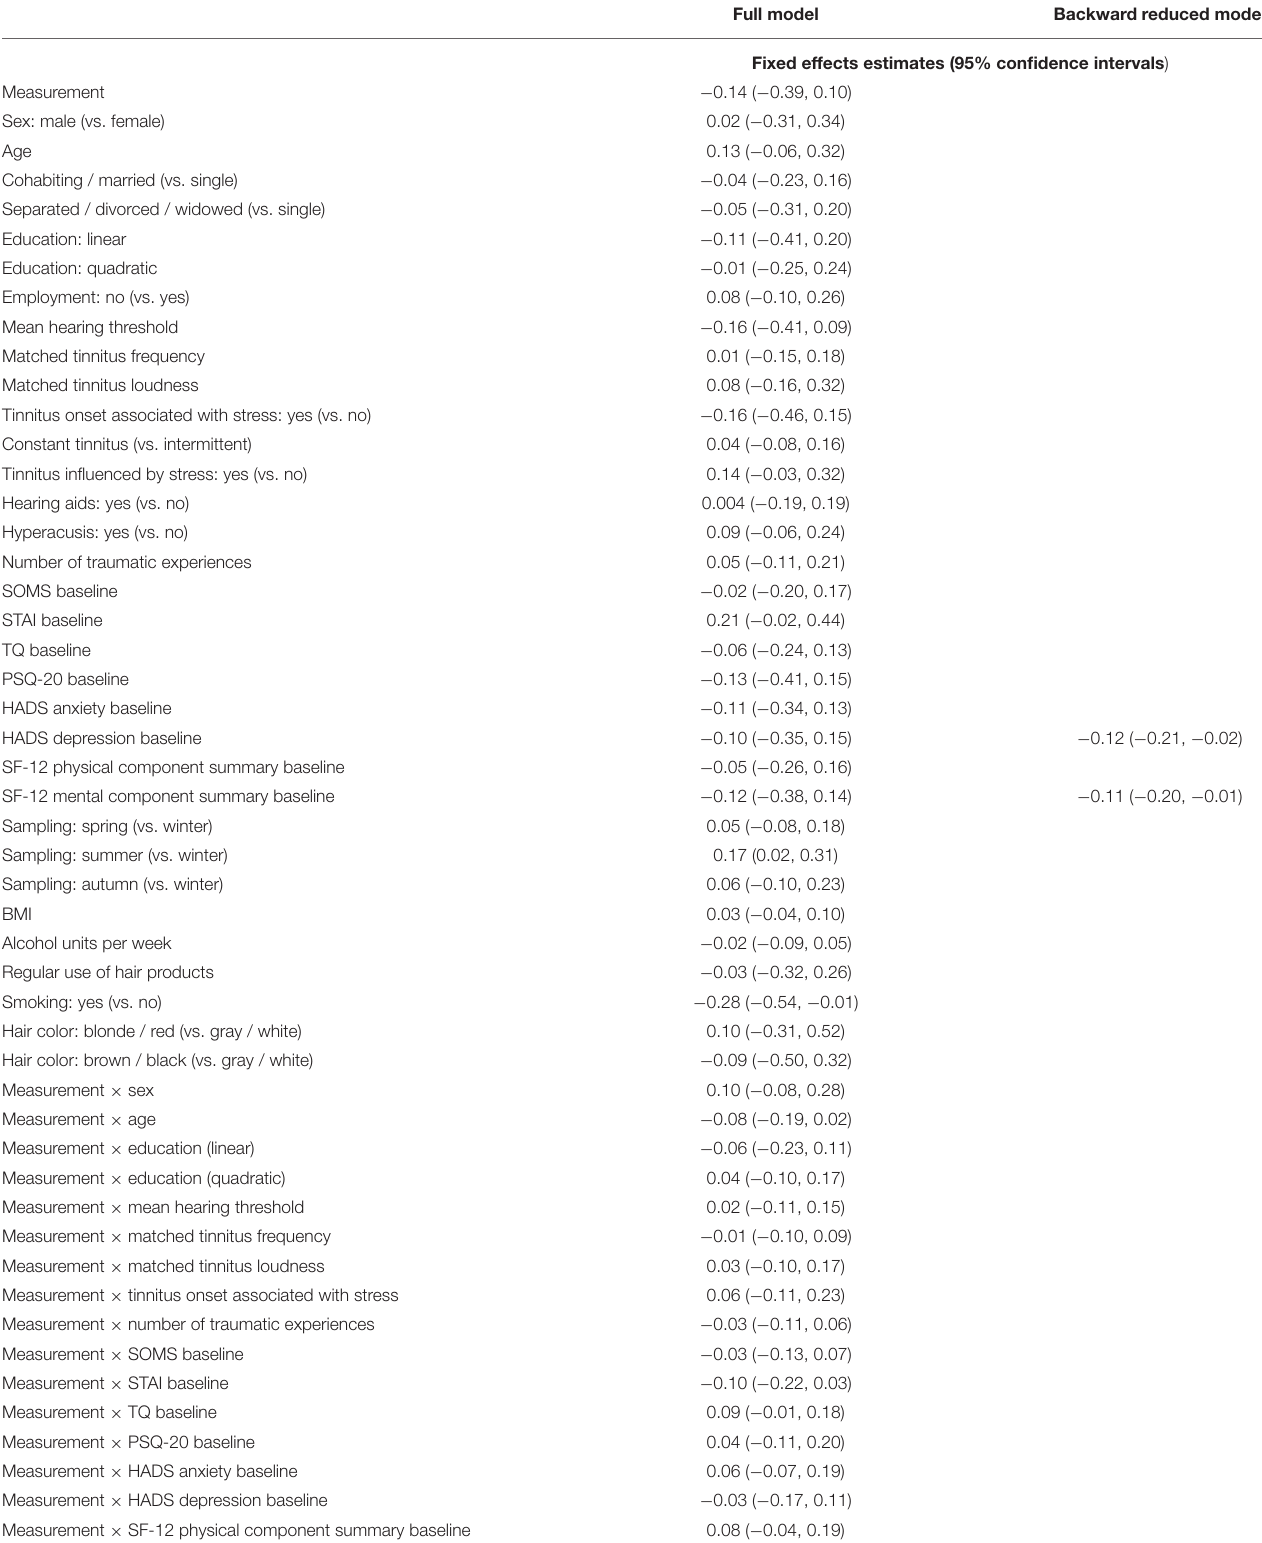
TABLE 5 | Full and backward reduced linear mixed-effects models for change in hair-cortisol levels across baseline and follow-up ( N =